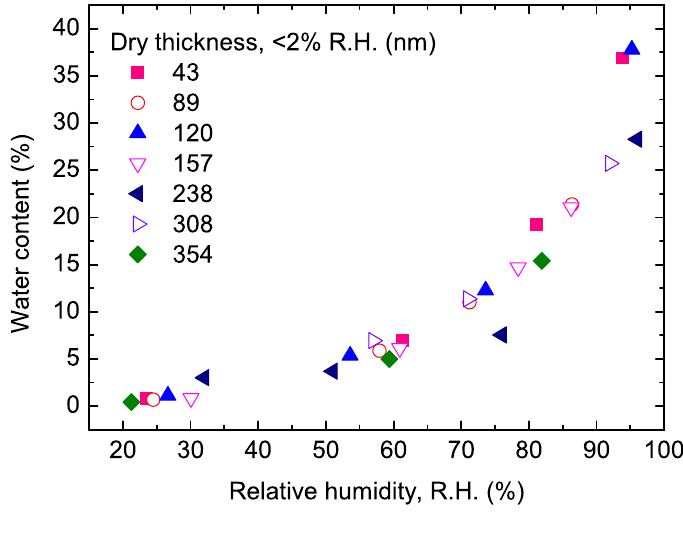
Figure 3. Water uptake in dependence of the relative humidity for various poly-( N,N -(dimethylamino ethyl) methacrylate) (PDMAEMA) brush thicknesses.